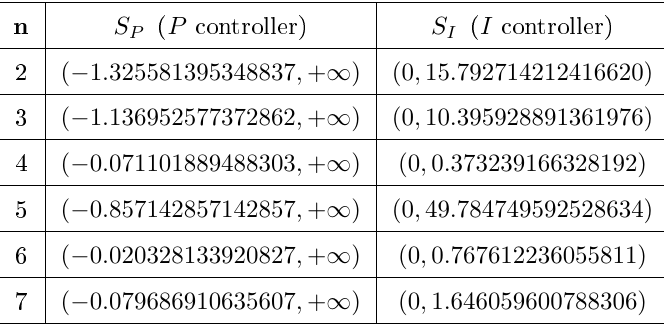
Table 4. Sets S P , S I of P and I